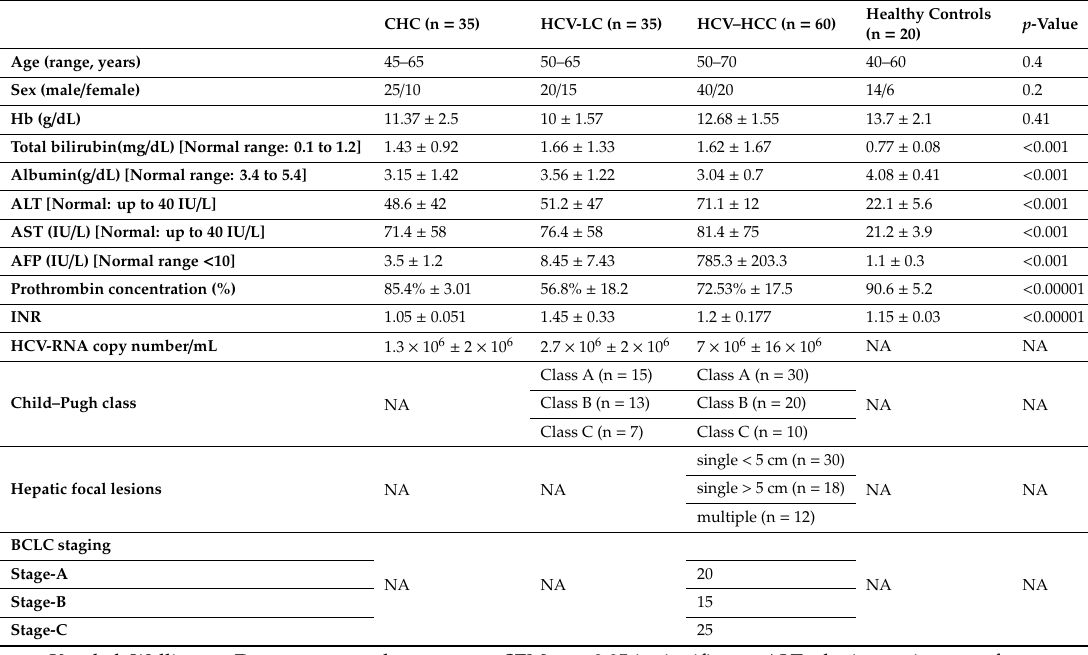
Table 1. Clinical and biochemical characterization of all groups enrolled in the